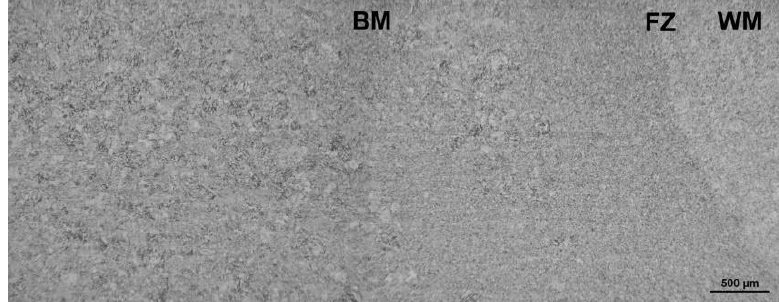
Figure 5. Light-optical micrograph of T92 / T92 weldment after the renormalizing-and-tempering PWHT-2.